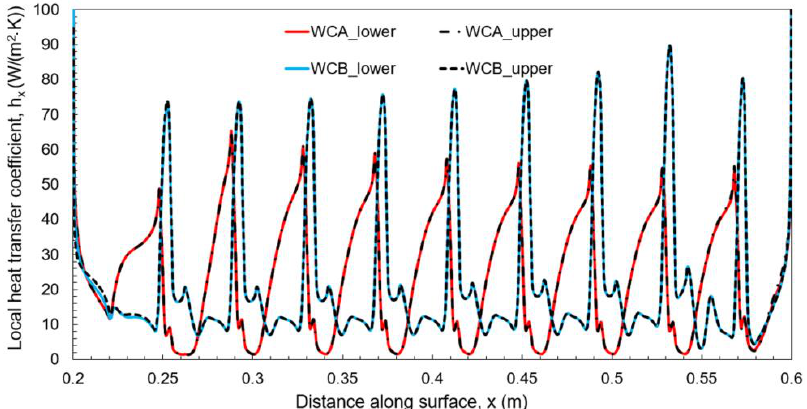
surfaces of WCA and WCB configurations for Q = 50 m 3